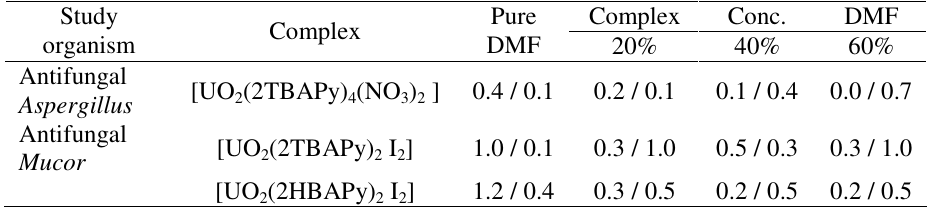
Table 8. Colony diameter/ Radial distance of colony around sample disc (cm).